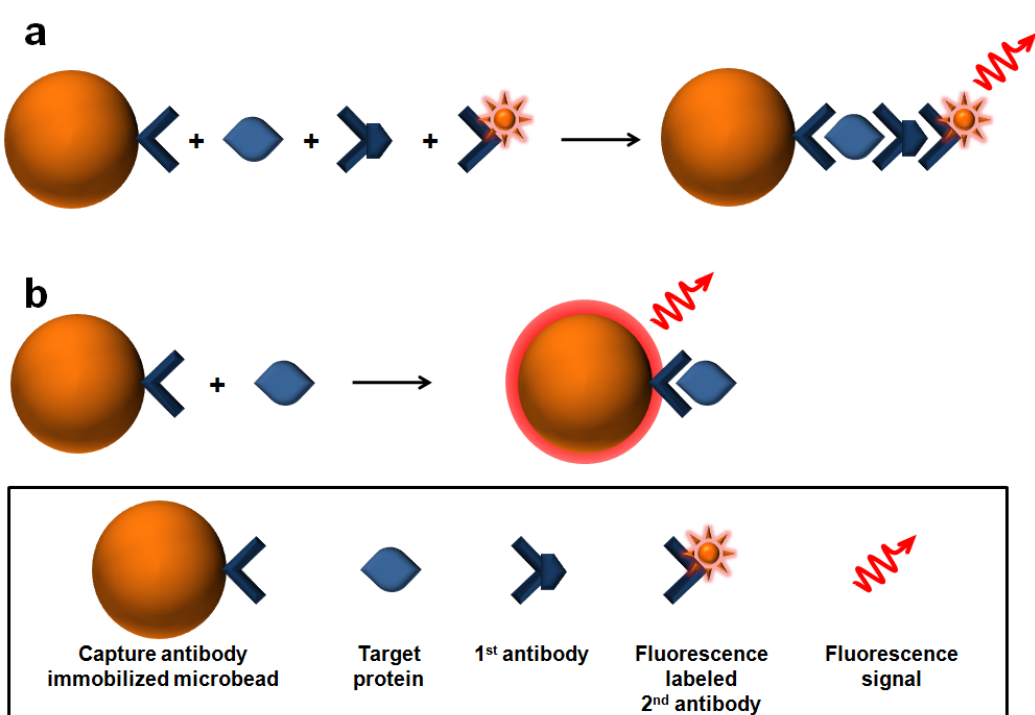
method; ( b ) label free